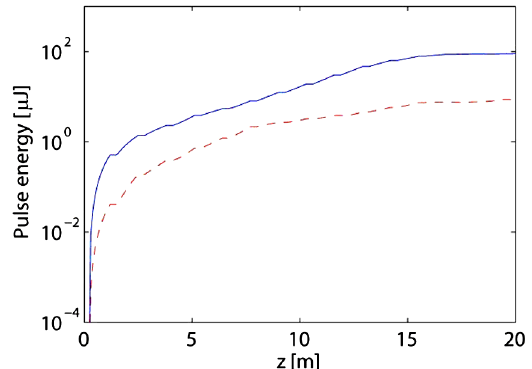
FIG. 5. Evolution of the soft x-ray FEL pulse energy along the radiator: comparison of the double-stage cascaded HGHG (red dashed line) and a single stage HGHG with three-dimensional phase space manipulation (blue solid line).